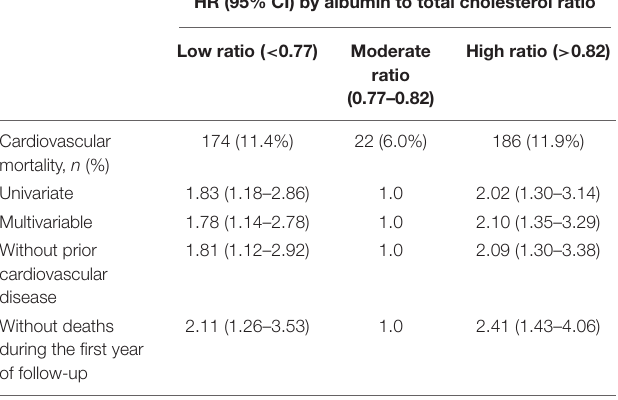
TABLE 4 | Association between albumin to total cholesterol ratio and cardiovascular mortality*. HR (95% CI) by albumin to total cholesterol ratio